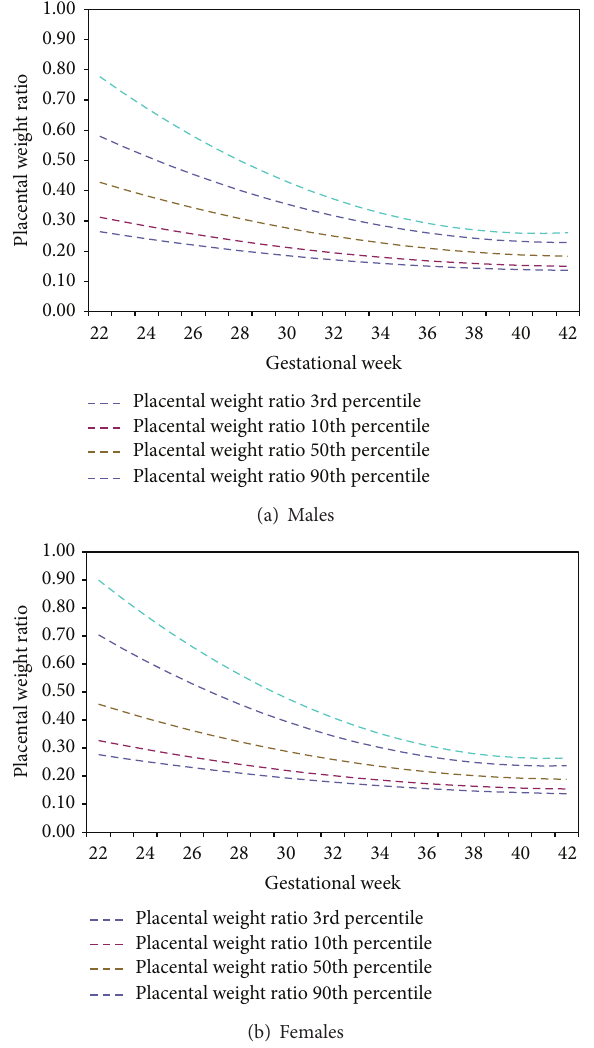
Figure 3: Inclusive of regional referrals PWR distributions by gestational